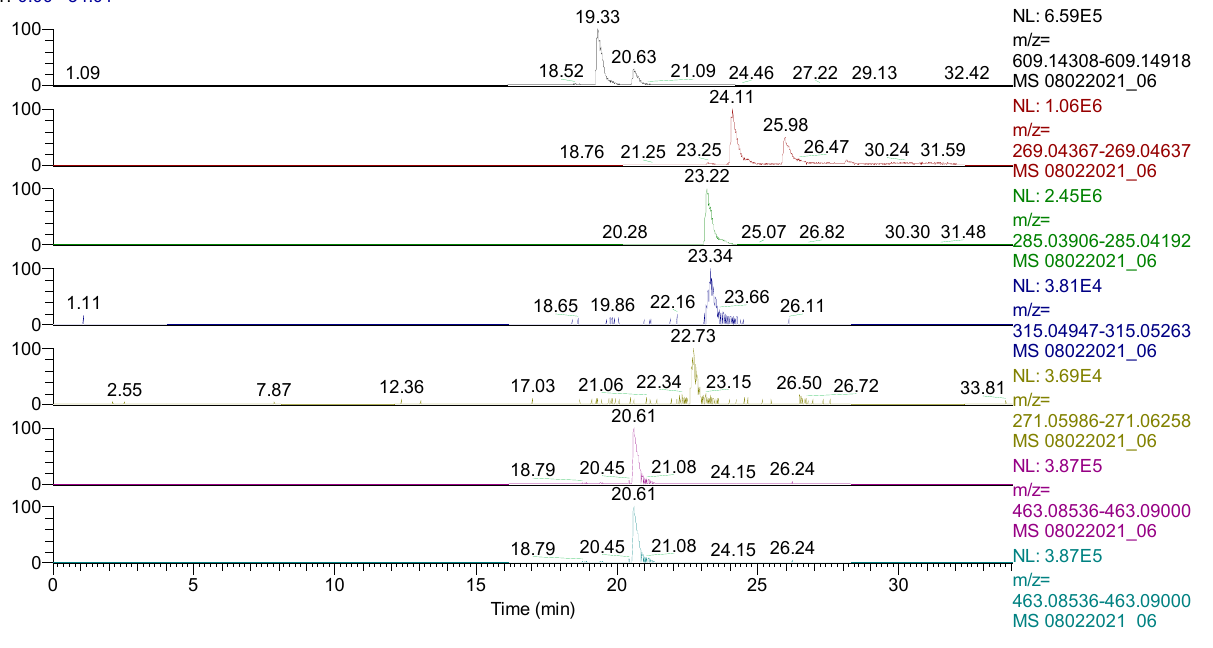
Figure 4. UHPLC–HRMS/MS chromatogram of TE in which were identified (top to bottom): rutin ( m/z : 609.14613, Rt: 19.33), apigenin/genistein ( m/z : 269.04502, Rt: 24.11), kaempherol ( m/z : 285.04049, Rt: 23.22), naringenin ( m/z : 271.06122, Rt: 22.73), and hyperoside ( m/z : 463.08768, Rt: 20.61).